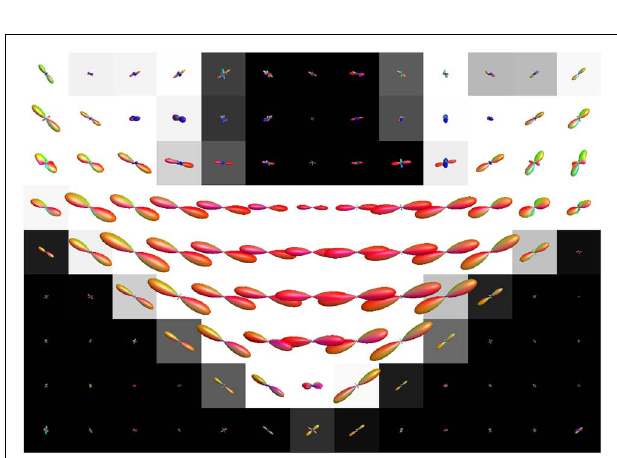
FIGURE 8 | Illustration of the effects of isotropic non-WM PVEs with CSF in corpus callosum with real data. WM tissue probability map estimated from high-resolution anatomical MRI is visualized in the background, and fODFs estimated with CSD using up to eighth-order SH are